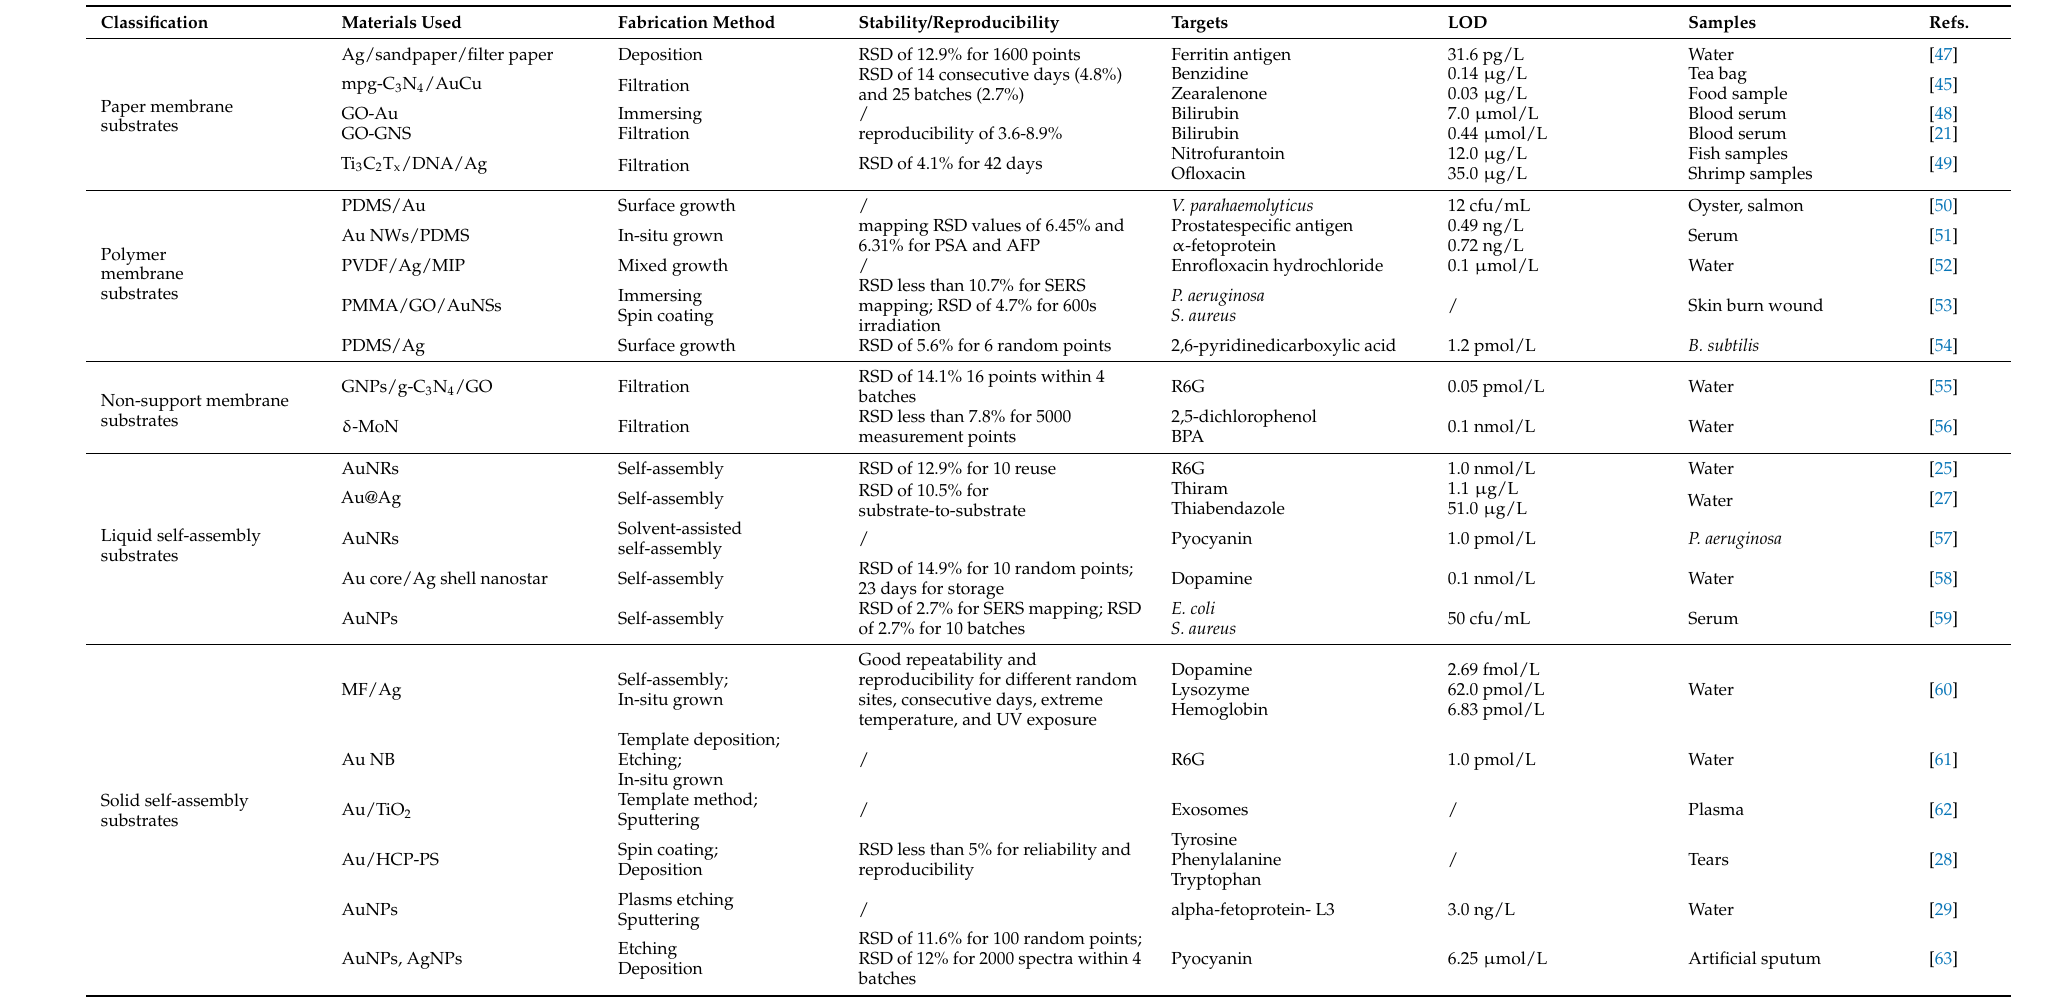
Table 1. Summary of representative solid SERS